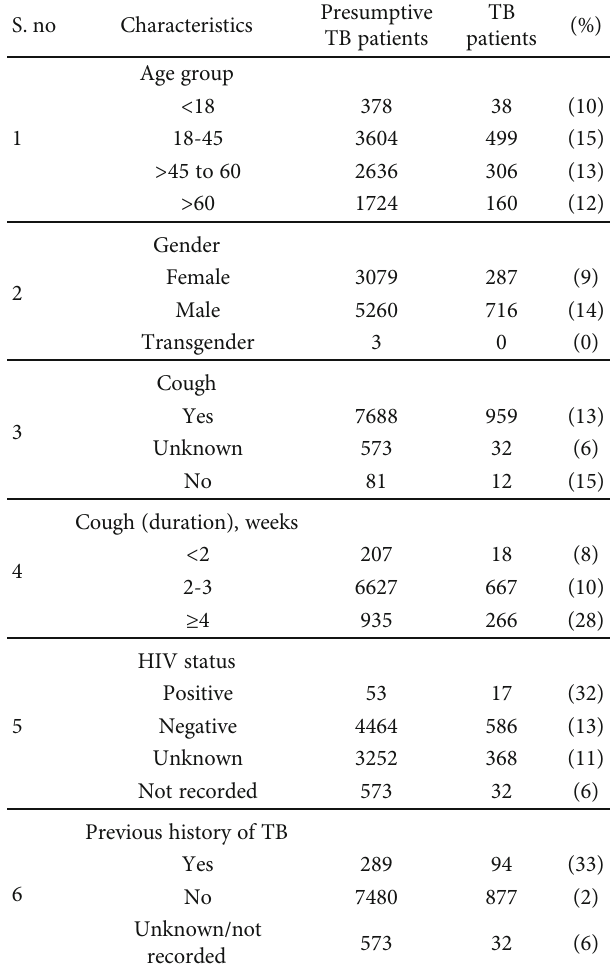
Table 7: Proportion of TB cases detected among di ff erent characteristics of presumptive TB patients under RIPENED project, Telangana State, India, during 2018-19 ( N = 8342